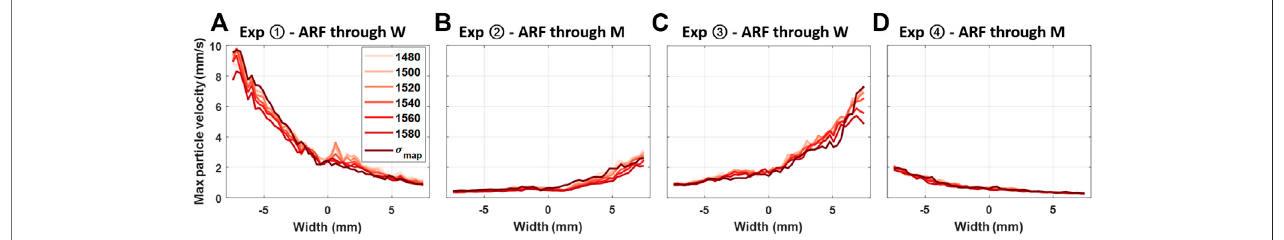
FIGURE 5 | Maximum shear-wave particle axial velocity values for the four experimental con fi gurations, with each line showing the velocity observation from the same MA-PWI data but using different SoS assumptions in beamforming, that is, constant values from 1,480 to 1,580 m/s vs. a spatial map σ map .